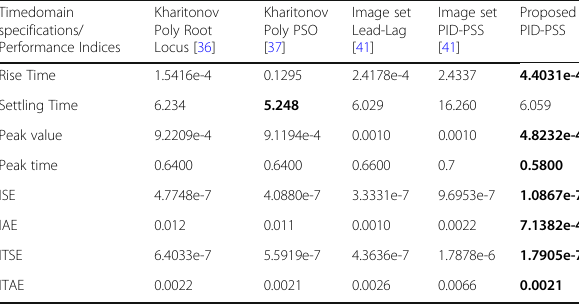
Table 6 Comparision of performance measures between the proposed and existing methods at P = 0.2 p.u . and Q = -0.4p.u